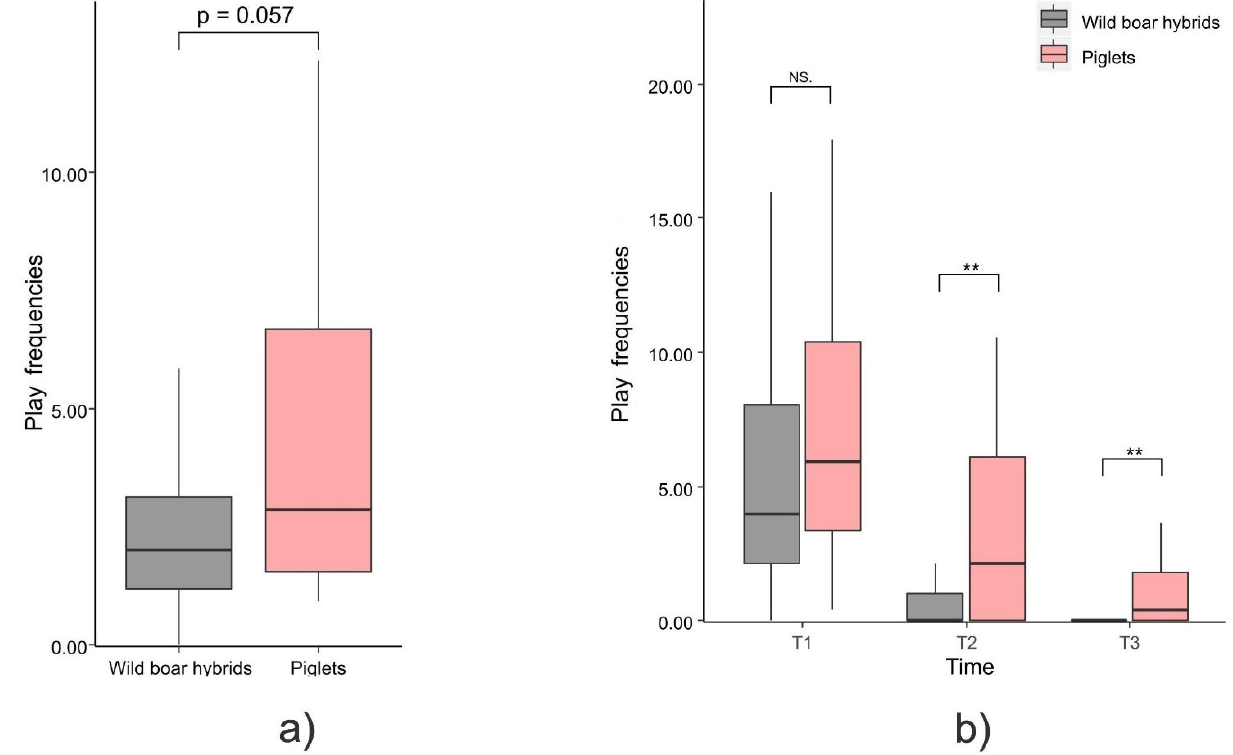
Figure 2. Box plot showing that: ( a ) the overallsocial play frequency tends to be higher in piglets than wild boar hybrids for the whole period (Mann–Whitney exact test; p = 0.057); ( b ) social play hourly frequencies (age periods: T 1 = 6 – 20 days, T 2 = 21 – 35 days, T 3 = 36 – 50 days) are higher in piglets in T 2 (Mann – Whitney exact test; p = 0.006) and in T 3 (Mann – Whitney exact test; p = 0.001). There was a significant decrease in the social play levels across periods for both hybrids and piglets (Friedman’s tests, p < 0.05) and particularly between T 1 and T 2 /T 3 (Dunn’s tests: p < 0.05). Horizontal line: median value; box: interquartile range; vertical line: minimum and maximum values in the data. NS = non-significant, ** = p <